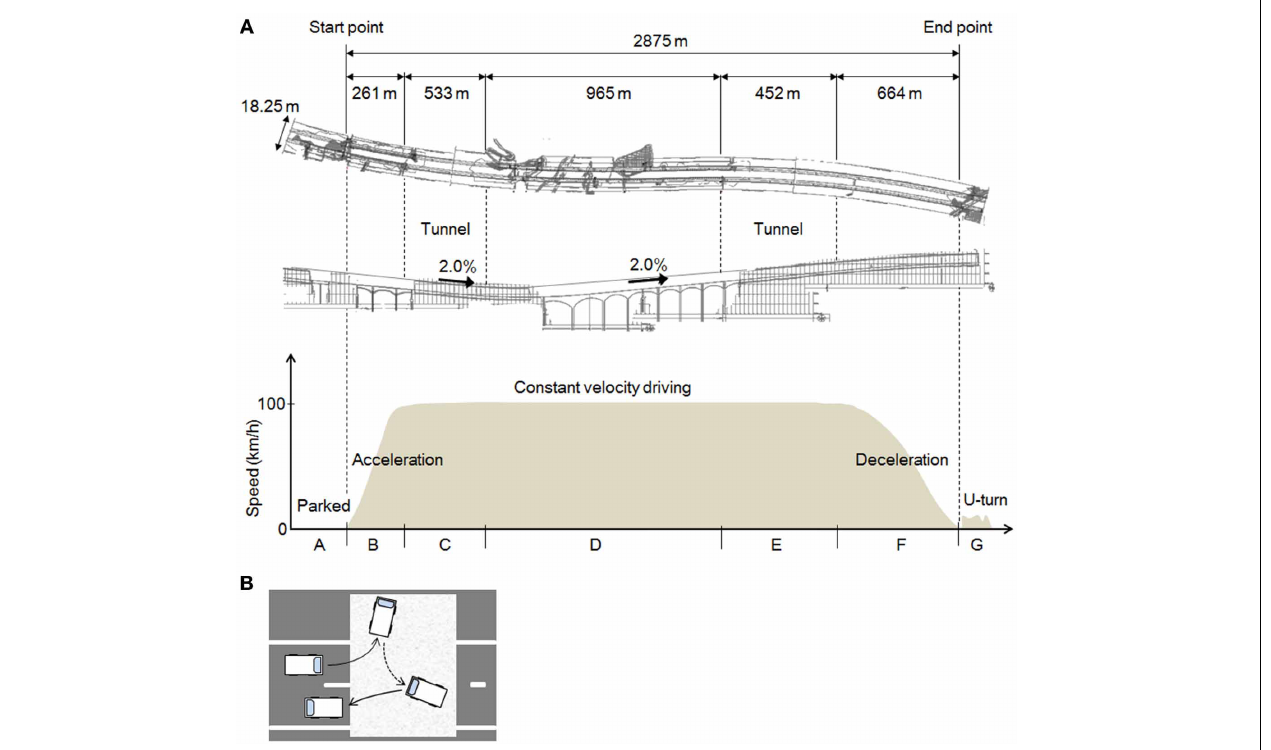
FIGURE 2 | The experimental field and the tasks. (A) The experimental task. The shape of the road as viewed from above; a longitudinal view; and a graph of the driving task and vehicle speeds in each section